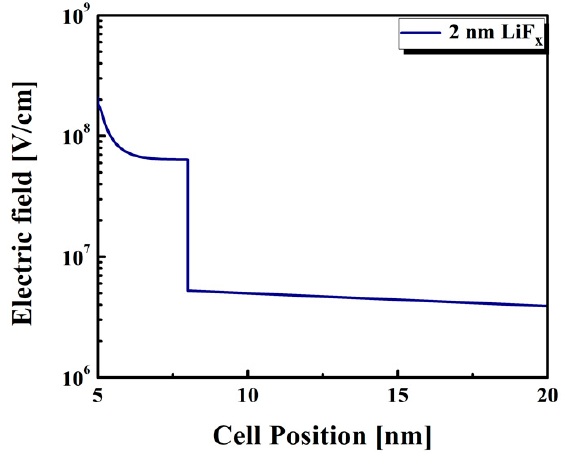
Figure 4. Electron field of SHJ solar cell for a 2 nm thick LiF x as an electron carrier selective contact layer.